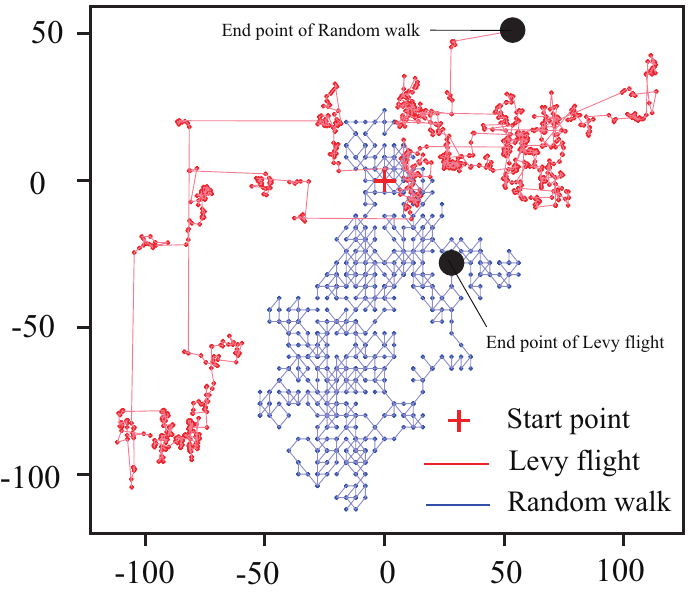
Figure 3. Schematics for typical searching process of Lévy flights and random walk in 2000